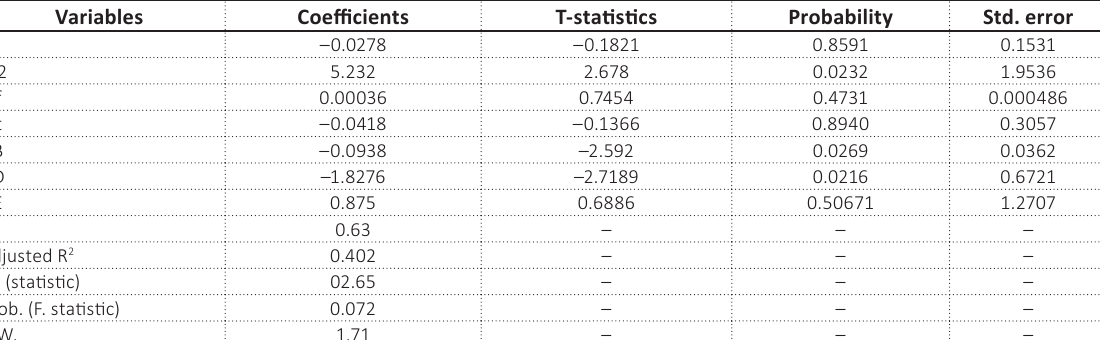
Table 1. Hypothesis testing and